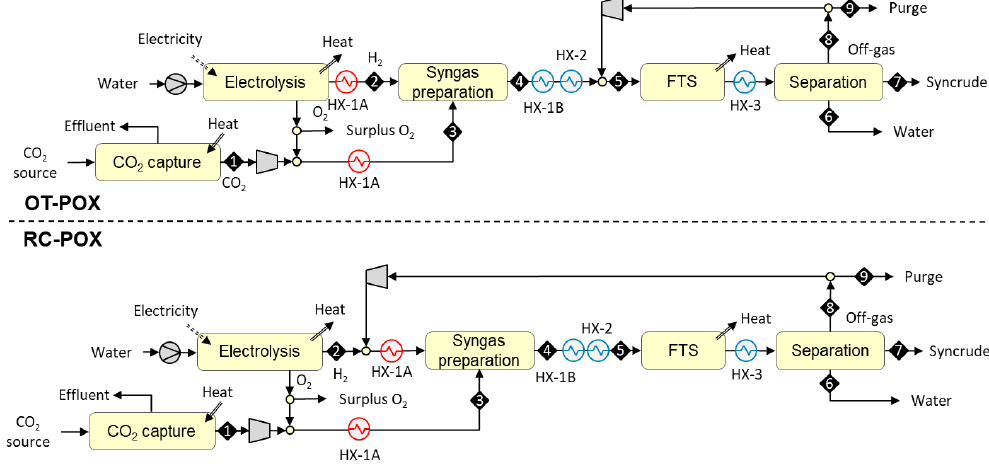
Figure 3. Block diagrams for the once-through autothermal from partial oxidation (OT-POX) and recycle autothermal from partial oxidation (RC-POX) configurations based on autothermal heating from partial oxidation.